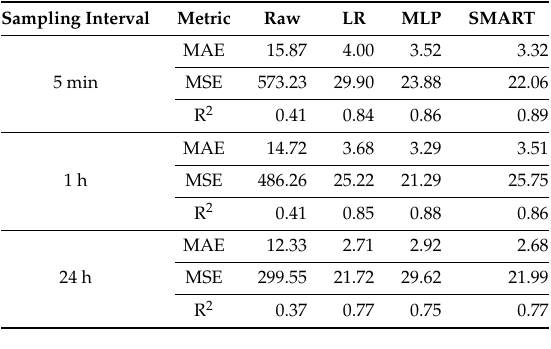
Table 6. Comparison of performance by sampling intervals (5 min/1 h/24 h: 80%—training dataset, 20%—test dataset, shuffled method).